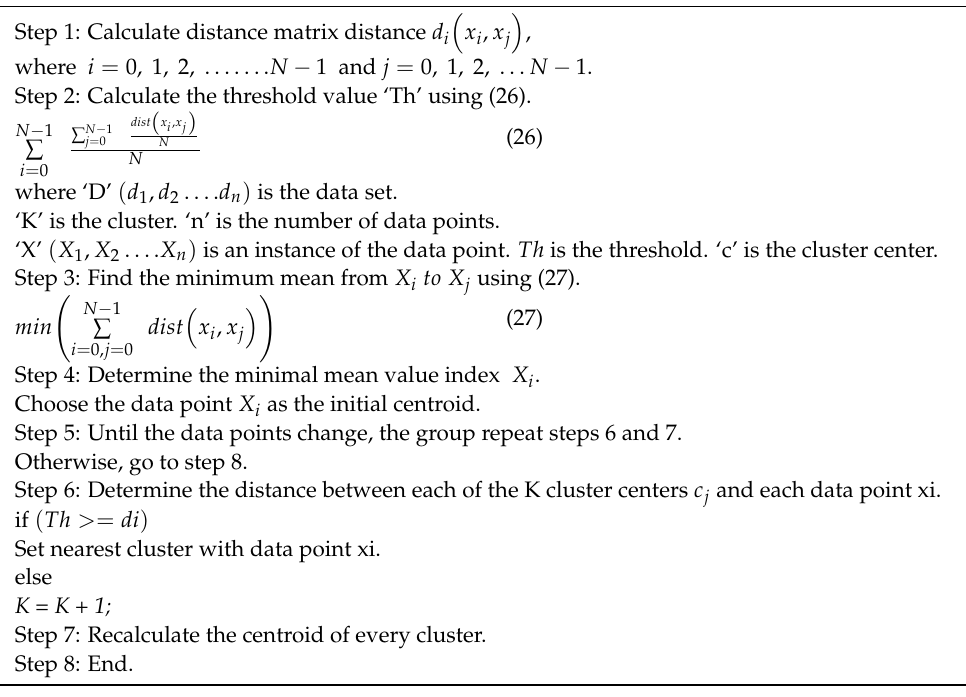
Algorithm 1. Modified K-Mean clustering.